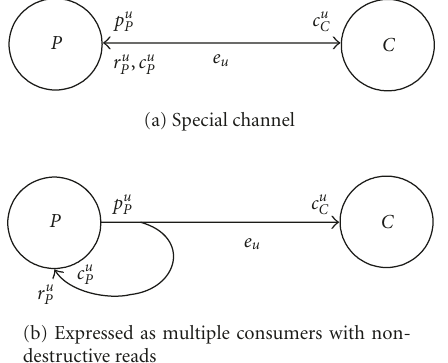
Figure 7: Special case of the multiple consumers with nondestruc- tive read: a nondestructive read-back at the producer side.